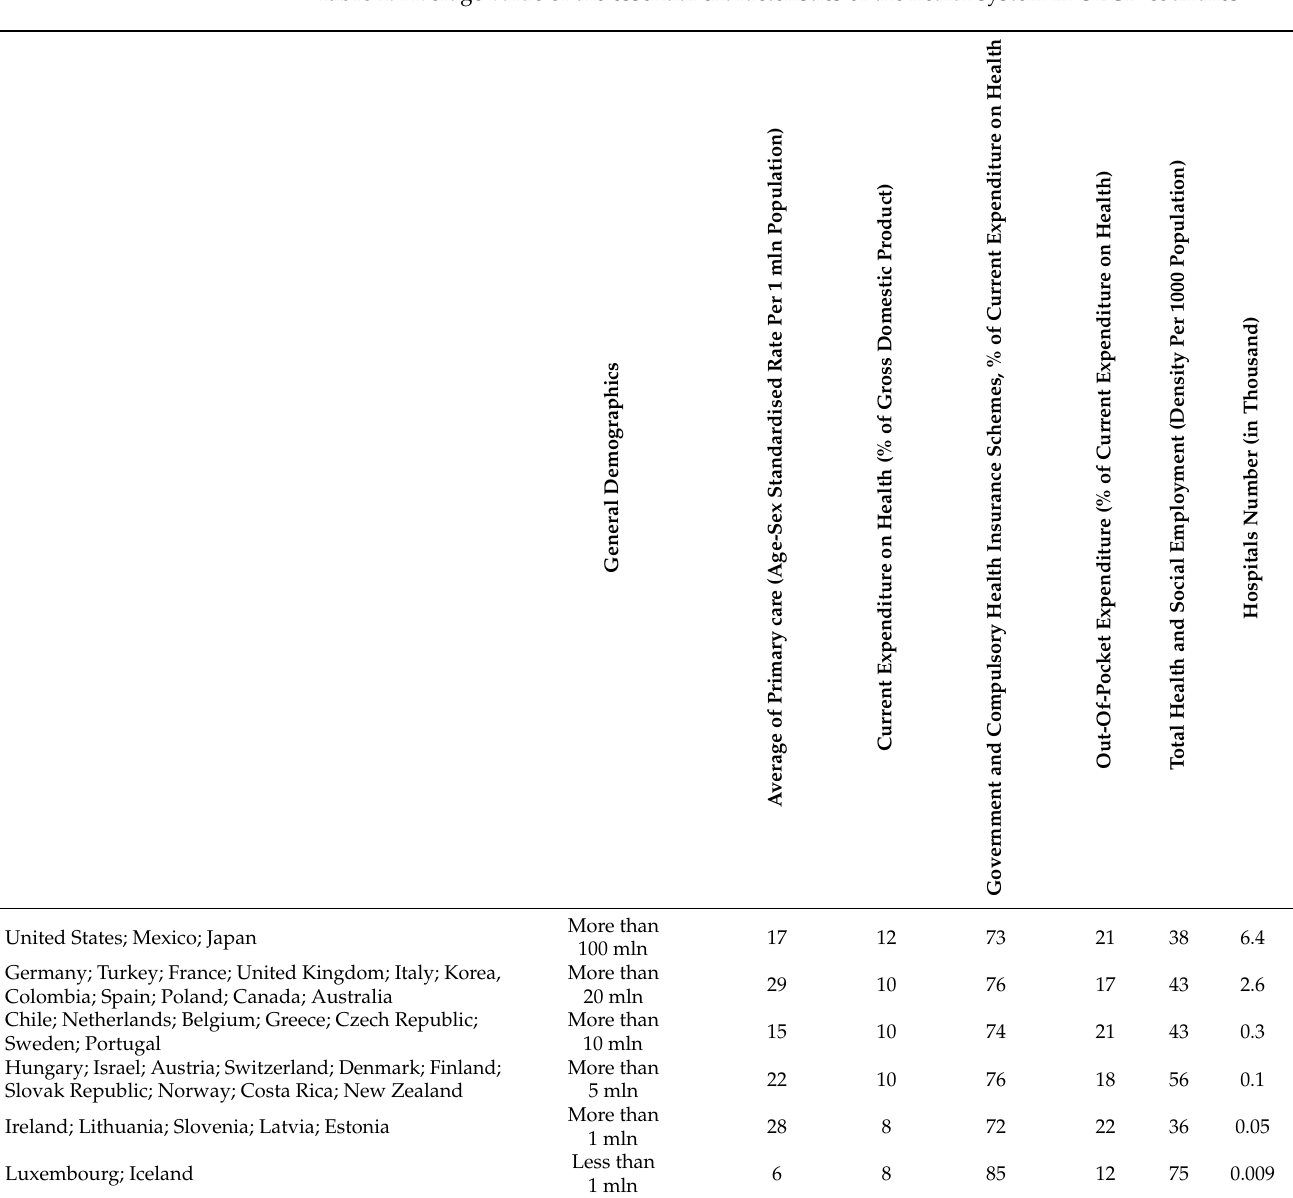
Table 1. Average value of the essential characteristics of the health system in OECD